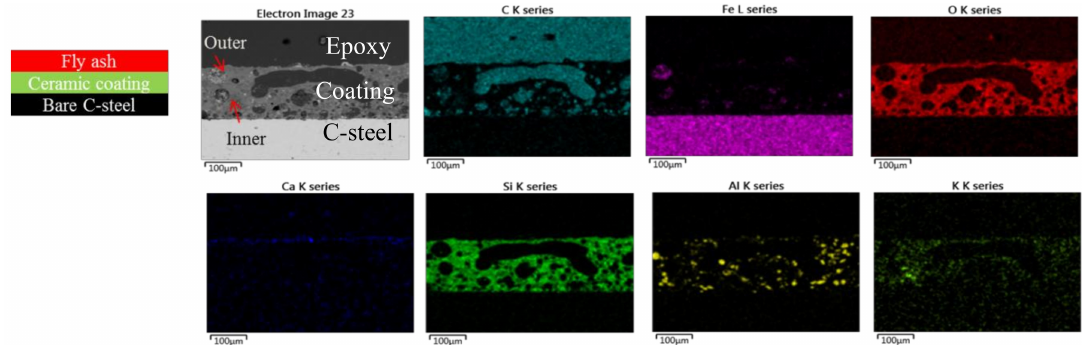
Figure 9. EDS maps of the cross-sectional surface of the coated steel after the anti-fouling testing.